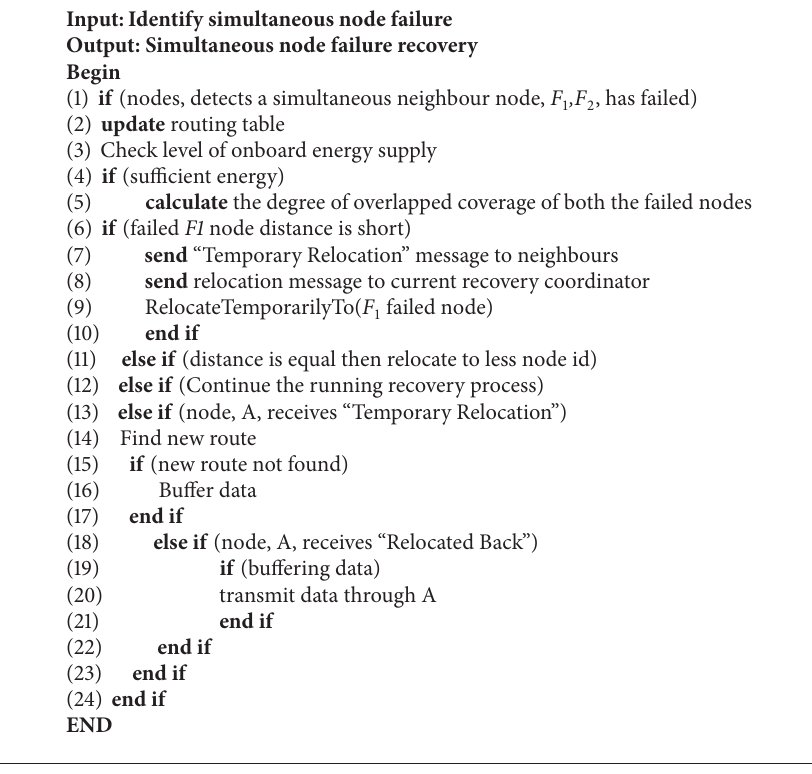
Algorithm 1: Recovery process when simultaneous node failure occurs. During recovery process simultaneous-node failure